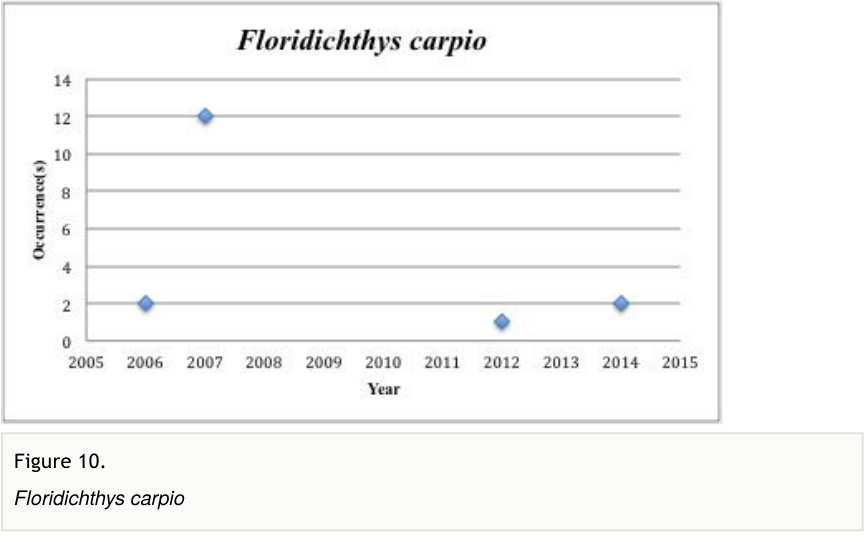
Figure 10. Floridichthys carpio